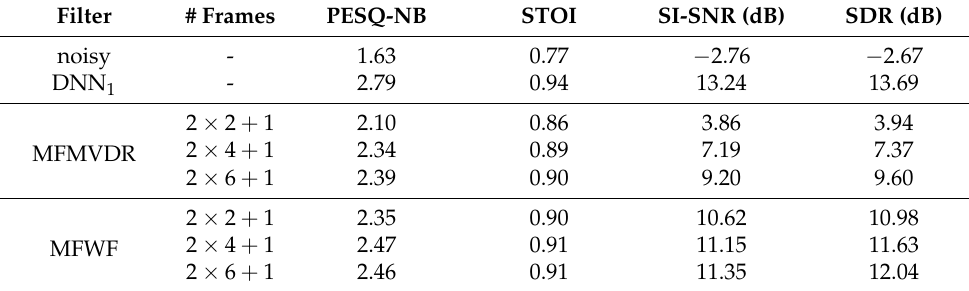
Table 2. The effect of the number of frames on different filters.